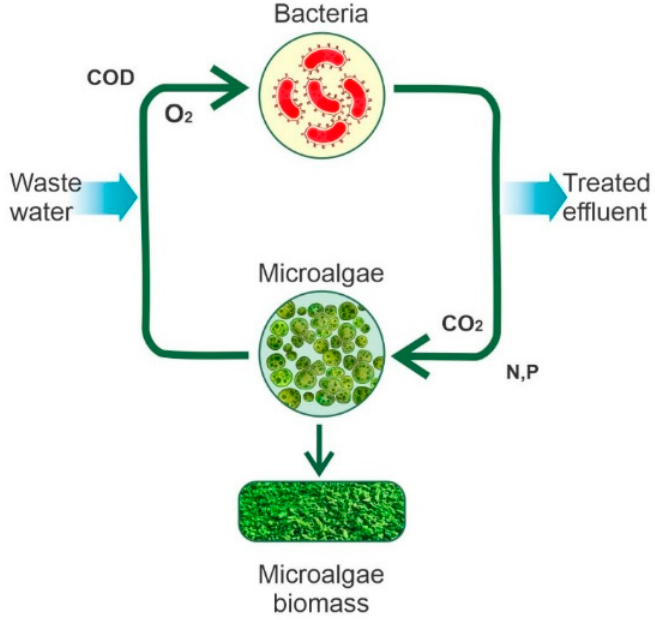
Figure 2. Symbiotic process between microalgae and bacteria in wastewater treatment [54].